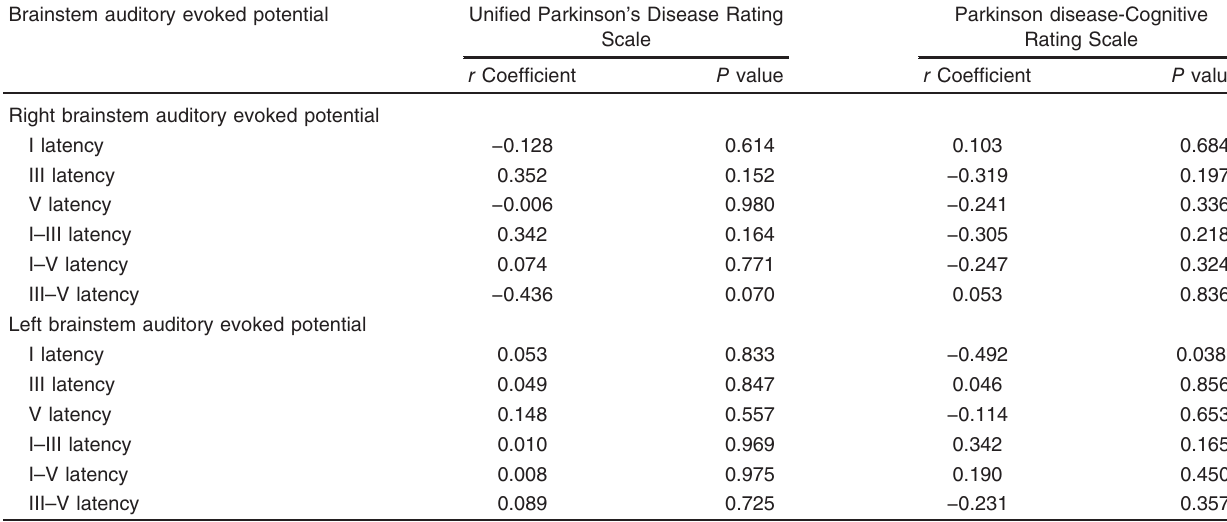
Table 6 Correlation between brainstem auditory evoked potential latencies and Unified Parkinson ’ s Disease Rating Scale and Parkinson disease-Cognitive Rating Scale in patients with Parkinson disease Brainstem auditory evoked potential